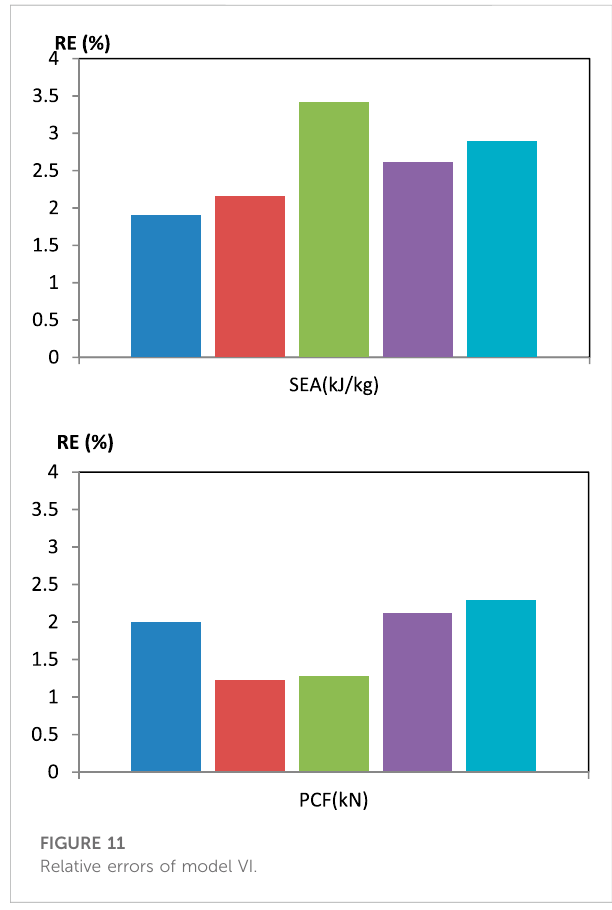
FIGURE 11 Relative errors of model VI.